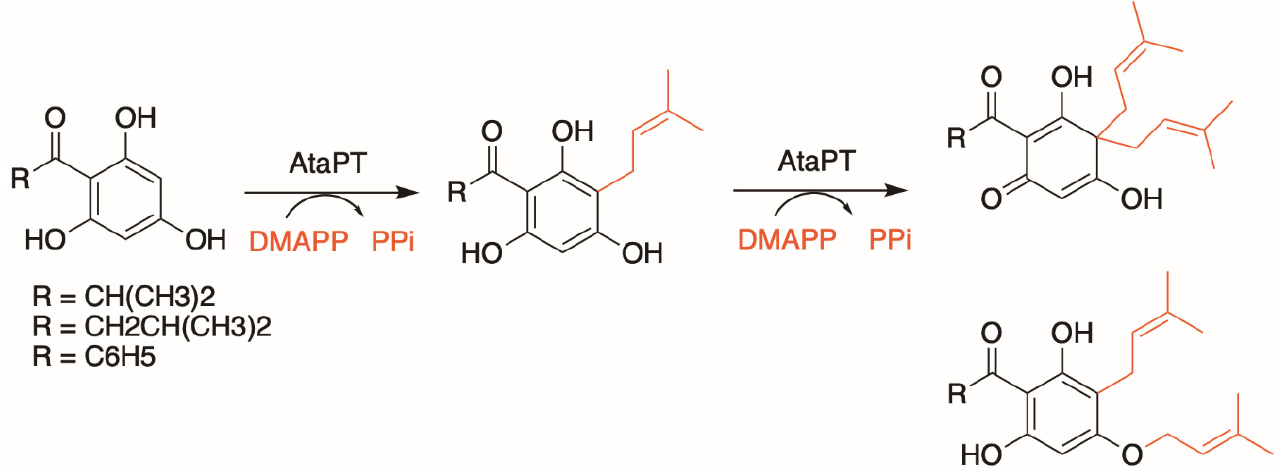
Figure 6. At aPT catalyzes predominantly C-monoprenylation of acylphloroglucinols but can also form gem -diprenylated products with DMAPP as the prenyl donor, as well as C- and O-diprenylated derivatives.